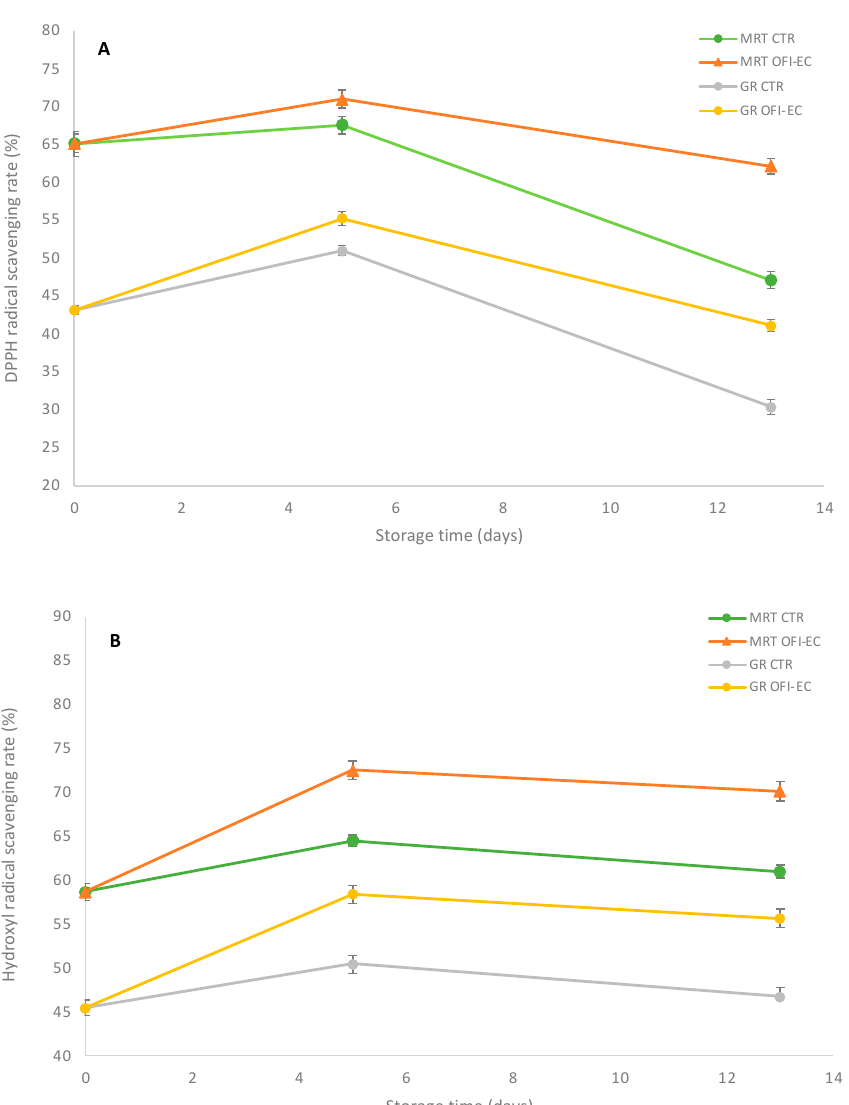
Figure 5. DPPH radical scavenging rate ( A ) and hydroxyl radical scavenging rate ( B ) in minimally processed loquat (cv Martorana and Gigante Rossa ), untreated fruit (CTR), and fruits treated with mucilage (OFI-EC) during cold storage (13 days at 5 °C). Data are the mean ± SE (bars represent standard error of the means; n = 5).